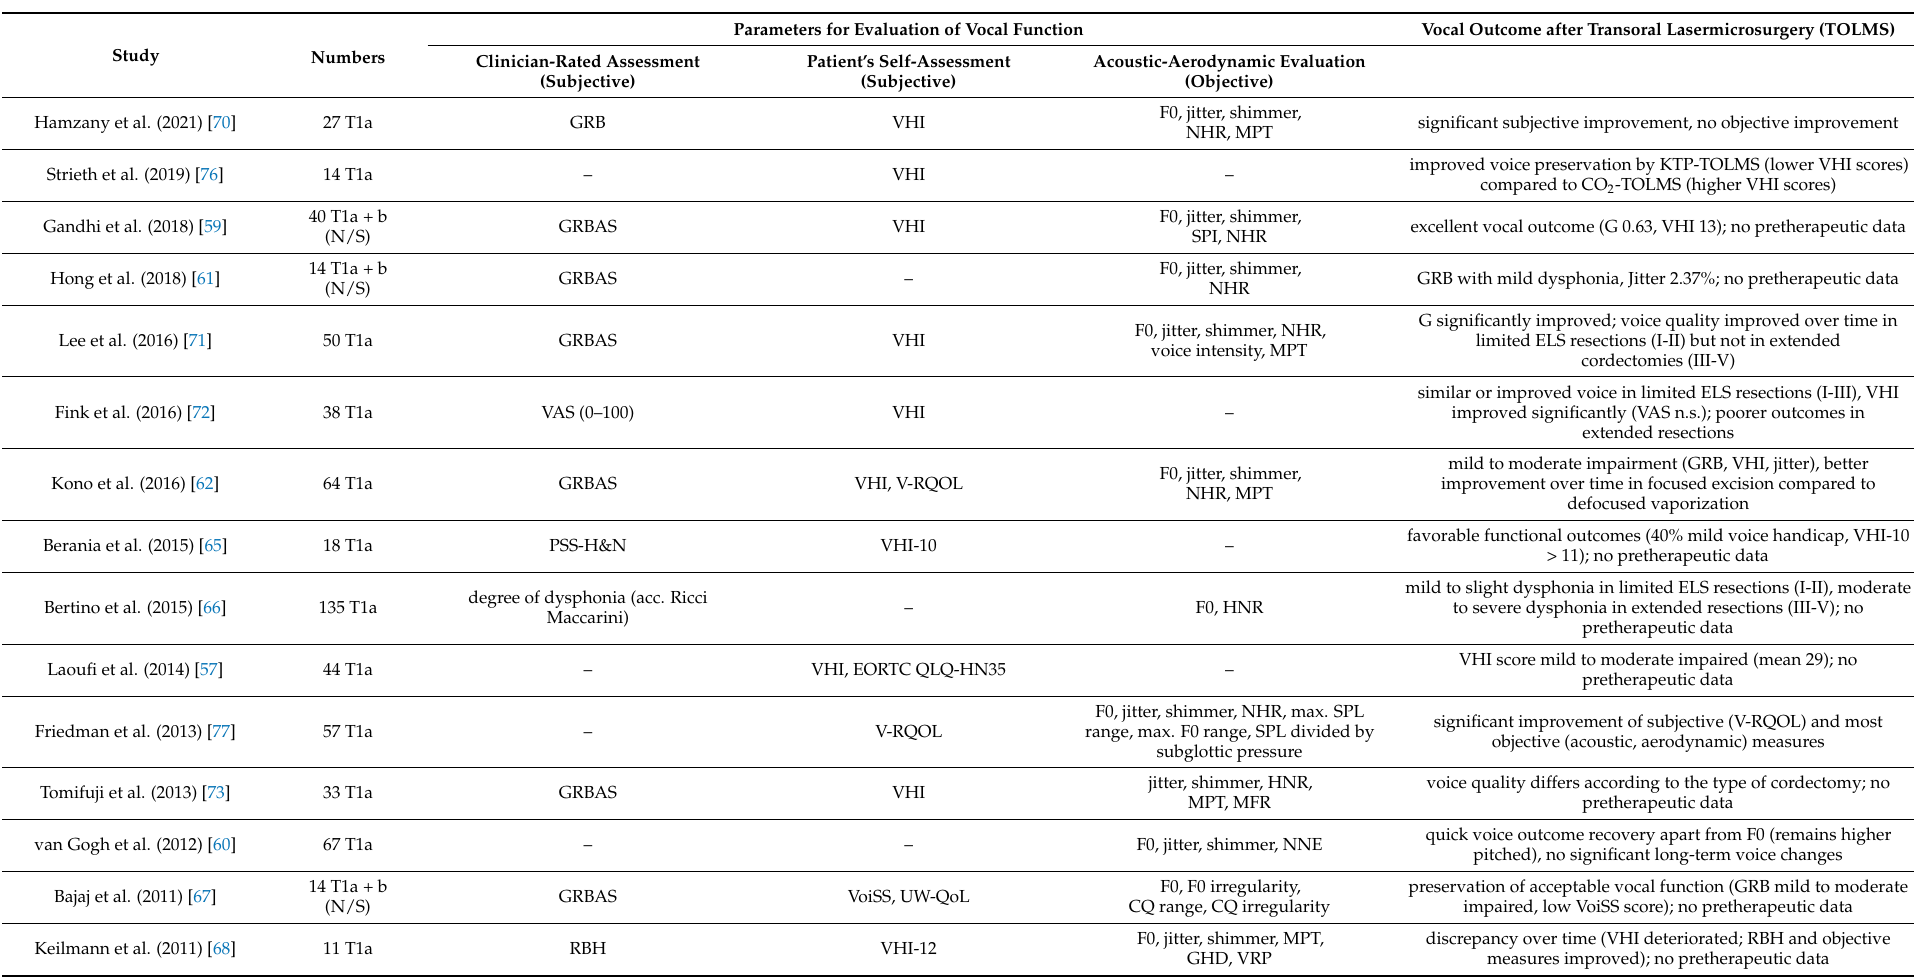
Table 3. Published vocal outcomes for T1a glottic cancer treated with TOLMS, taken from representative studies (last 14 years, n > 10 T1a patients operated via